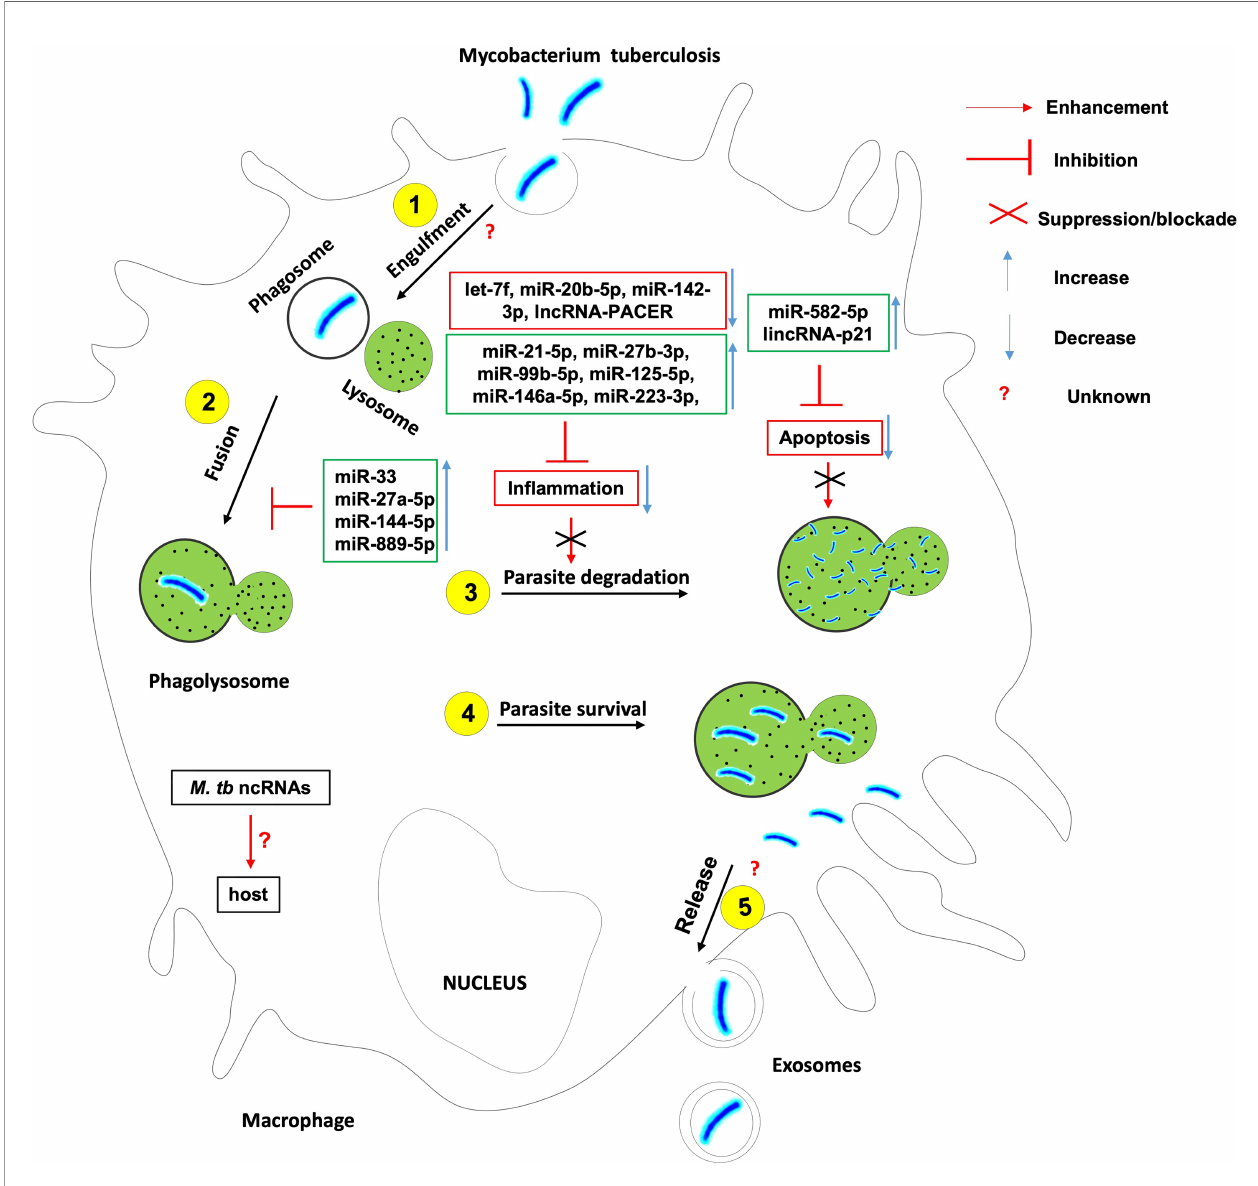
FIGURE 1 | The role of non-coding RNAs in the etiology of tuberculosis. Several ncRNAs enhance host effector killing functions against mycobacterium tuberculosis and favor the bacterium survival and persistence within the infected host. There is knowledge gap about 1- host ncRNAs that regulate the bacterium engulfment within phagosomes and release in extracellular vesicles such as exosomes; 2- the role of Mtb-derived ncRNAs on the outcome of Mtb-macrophage